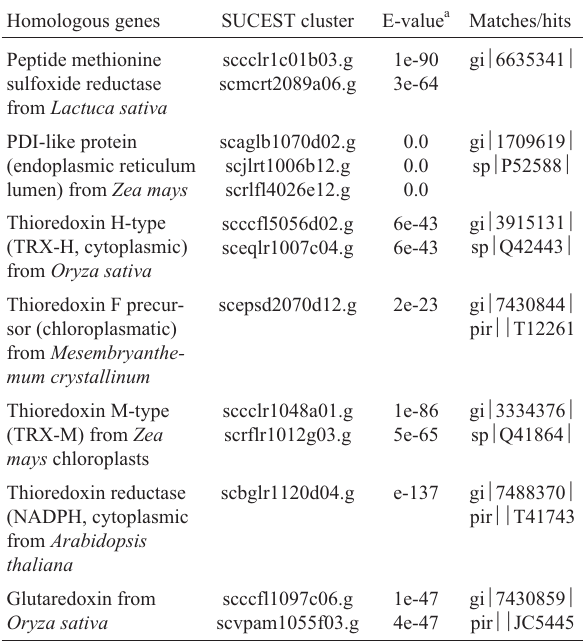
Table IX - Repair systems of proteins in sugarcane.